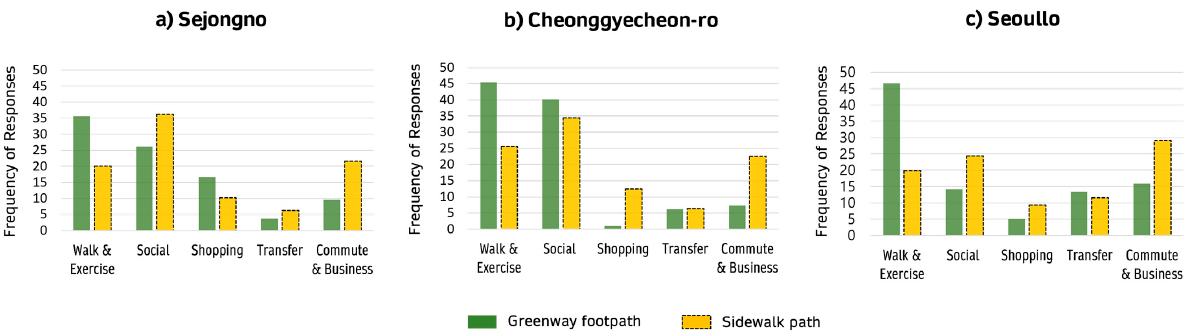
Figure 2. Reasons for visiting the sites.